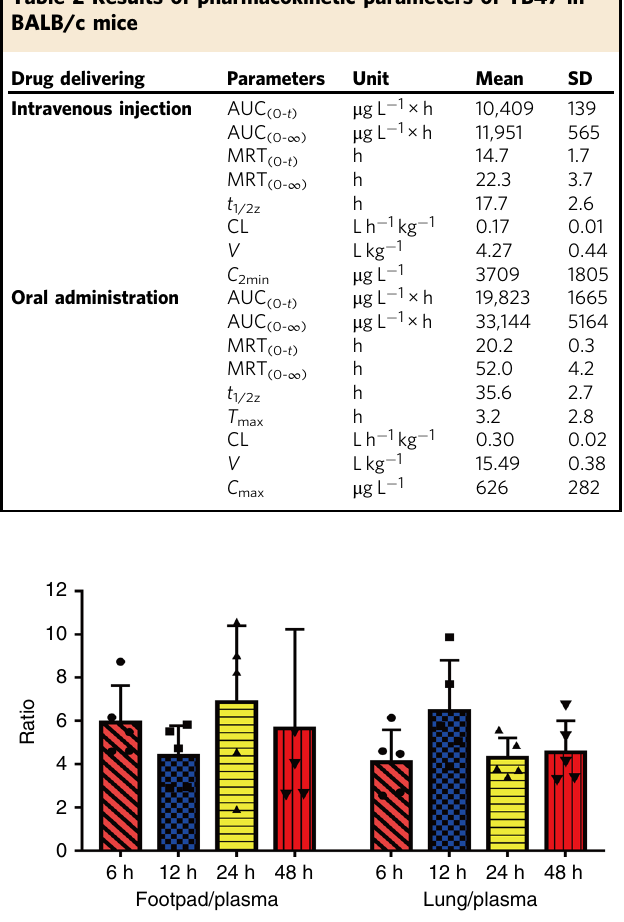
Fig. 6 The ratios of footpad/plasma and lung/plasma of TB47 concentrations. BALB/c mice were given a dose of 10 mg kg − 1 TB47 by oral gavage. Data are expressed as mean ± SD of fi ve